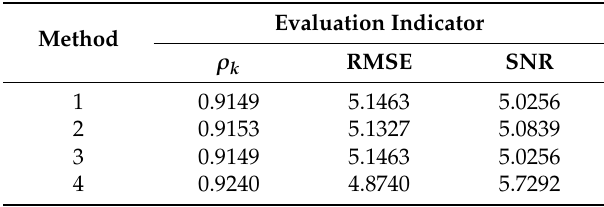
Table 4. Accuracy evaluation results of measured